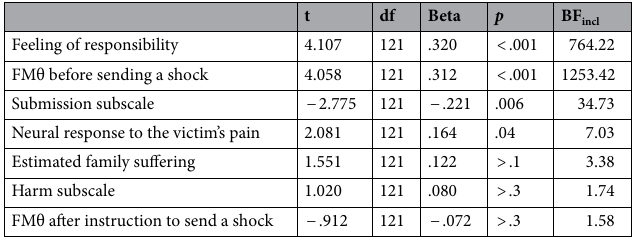
Table 1. Predictors of prosocial